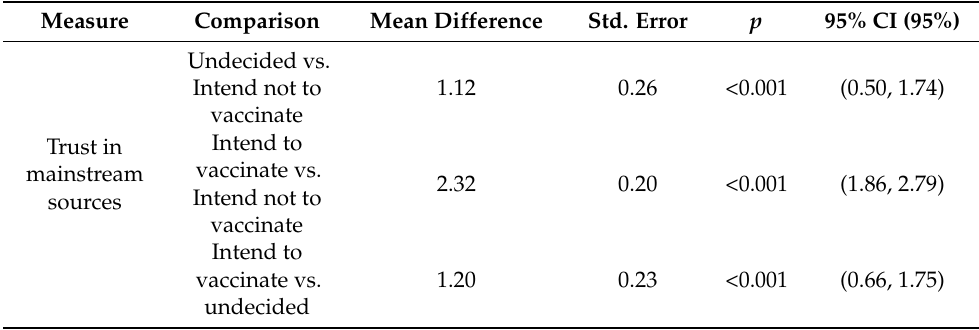
Table 5. Tukey post hoc comparisons of 8-item vaccine trust scores between vaccine intention groups among study participants in the US, 2020 ( N =